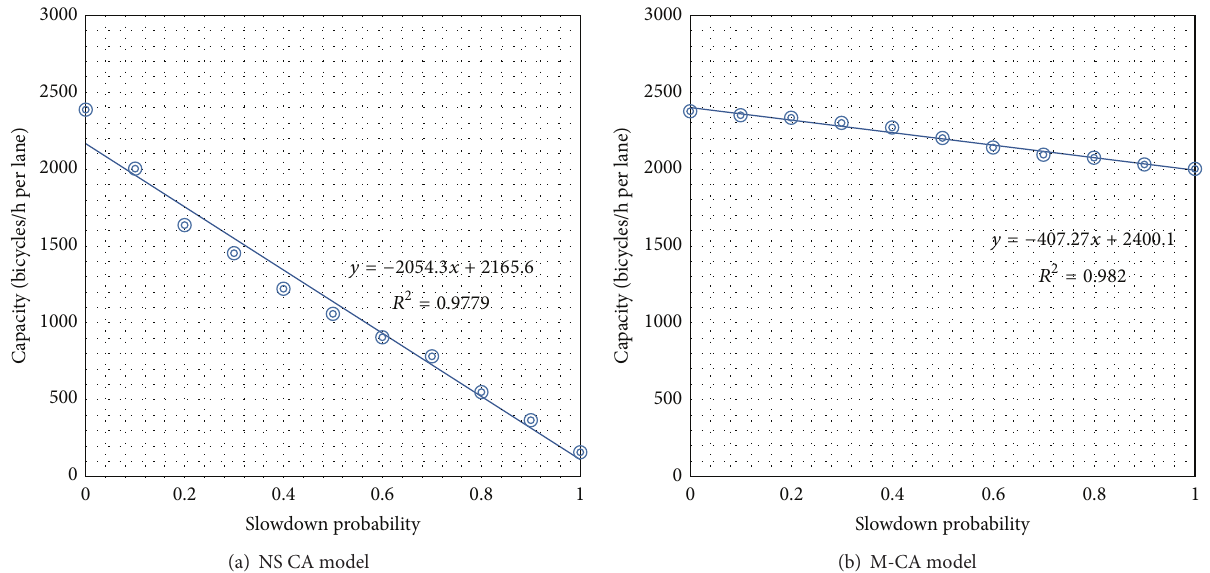
Figure 7: Simulated capacities of two CA models under different slowing down probabilities.